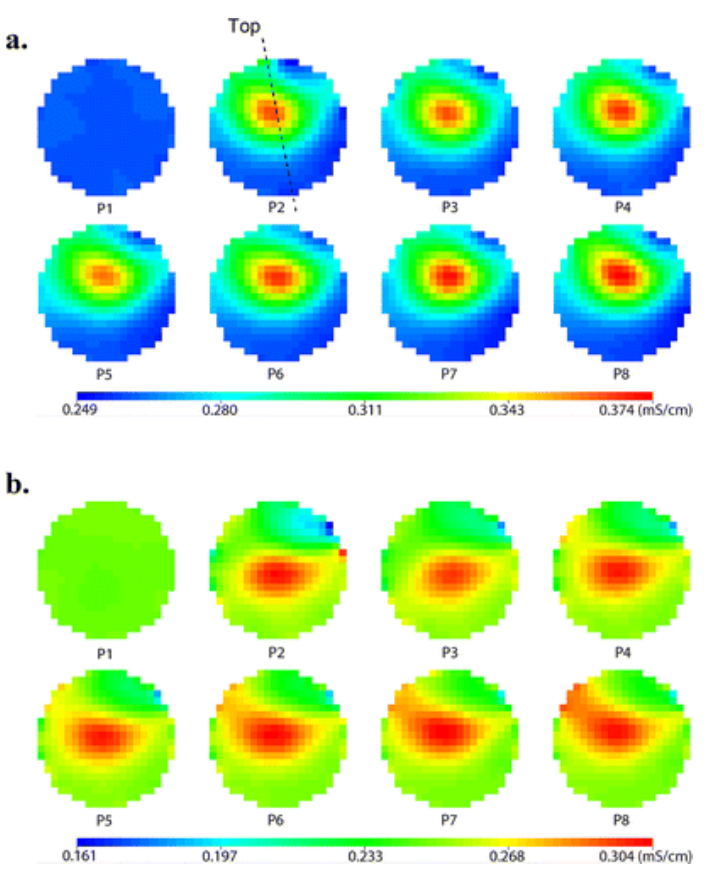
Figure 3. Softwood pulp suspension electrical tomography for Up = 0.5 m/s (main stream velocity), Cm = 2.0% and Dr = 0.05 (the injection tube length-to-diameter ratio), using sequential sensing planes (the location of the planes P1–P8 is from left to right in the flow direction, with P1 located before the injection point and the impeller), with ( a ) R = 12.2 (velocity ratio between main stream velocity and jet velocity) and N = 403 rpm (rotation speed); ( b ) R = 16.5 and N = 410 rpm. In all the images the injected tracer is represented by the high-conductivity region in red and yellow, whereas the main stream is represented by the low conductivity blue region. (Reproduced with permission from Yenjaichon et al. [54]).